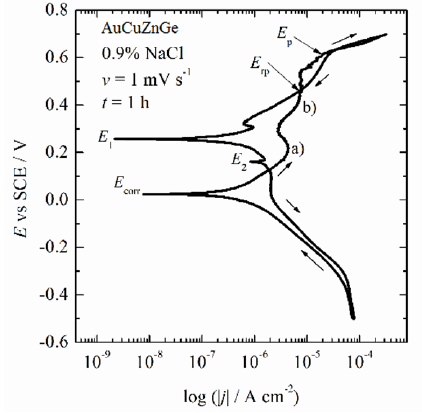
7 of 12 Figure 4. The dependence of the open-circuit potentials (right axis) and polarization resistance (left axis) after initial immersion ( • ) and after 24 h ( ο ) of immersion in 0.9 wt.% NaCl. After stabilization of the open circuit potentials, the polarization curve ( v = 1 mV s − 1 ) was recorded, Figure 5. In the forward scan, starting from − 0.5 V, oxygen reduction reac- tion under mixed activation–diffusion control occurred up to the corrosion potential of +20 mV, followed by the active alloy oxidation. Because the Tafel slopes for cathodic and anodic reactions were not well defined, the corrosion current density could be only esti- mated to be in the order of ~1 − 2 × 10 − 7 A cm − 2 . In the potential range of 0.15 V to 0.3 V a broad peak, (a), was observed, followed by a second, not well-defined peak, (b), in the potential range from ~0.3 V to ~0.5 V (SCE). Above potentials of ~0.5 V (SCE), initiation of metastable pitting was observed, followed by an increase of the current density at transi- tion or breakdown potential, E p of ~0.61 V (SCE), potentials. In the backward scan, re-